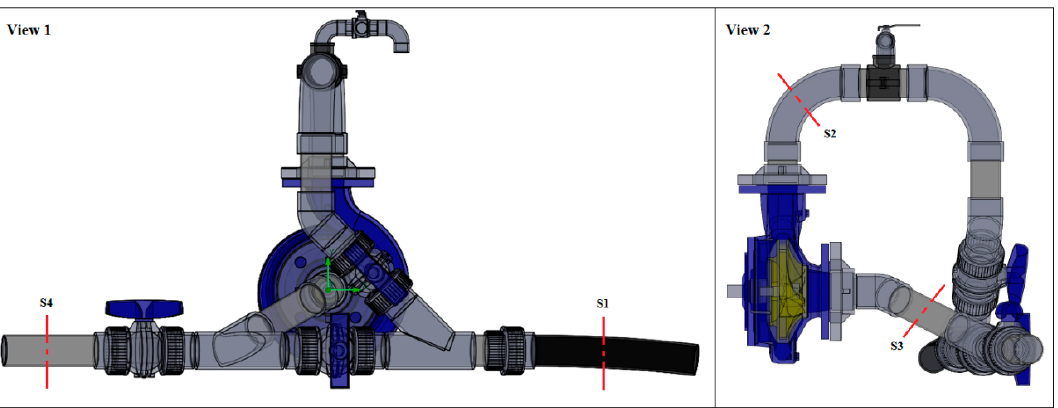
Figure 2. Ultrasonic doppler velocimetry (UDV) measurement points.